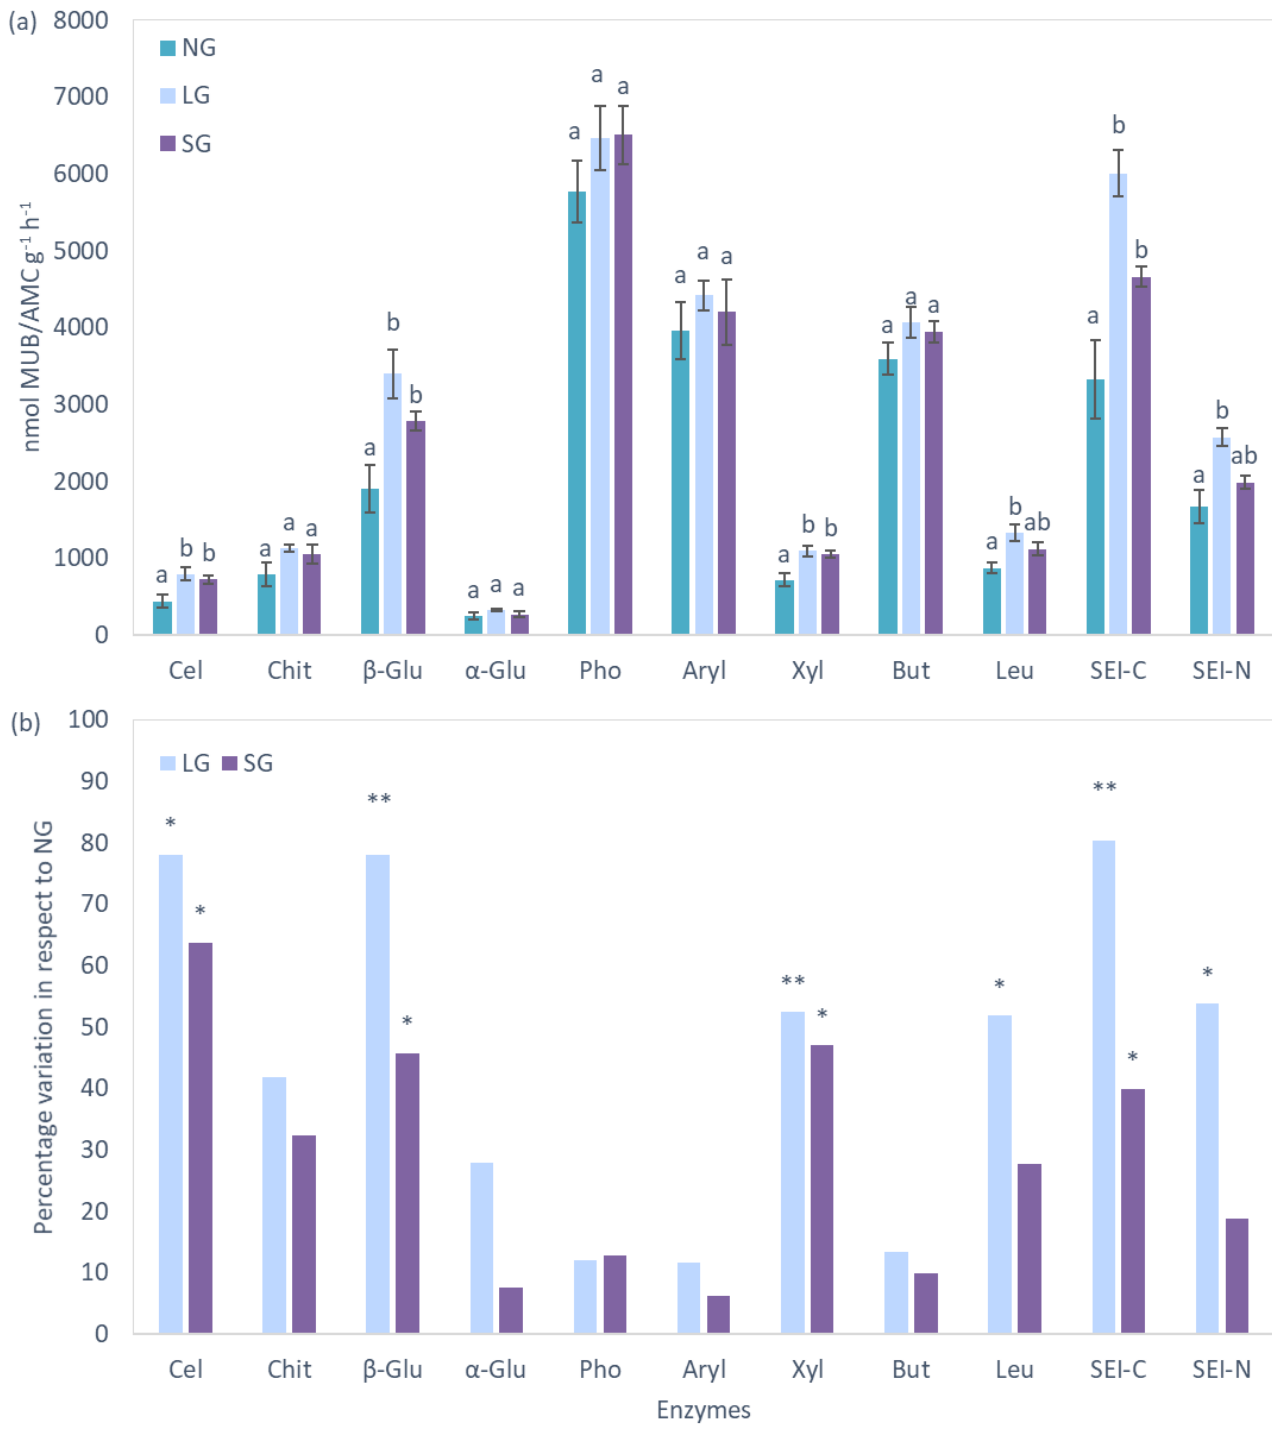
Figure 6. Soil extracellular enzyme activities and SEI index for enzymes involved in C and N cycles in grazed and non-grazed plots ( a ) absolute values (mean ± standard error), Letters next to the bars show the significance of ANOVA at p < 0.05; ( b ) percentage change in respect to non-grazed plots, significant differences with NG plots are indicated by * at p < 0.05 and ** at p < 0.01. Cel = β -cellobiohydrolase; Chit = Chitinase; β -Glu = β -glucosidase; α -Glu = α -glucosidase; Pho = acid phosphatise; Aryl = arylsulphatase; Xyl = β -xylosidase; But = butyrate esterase; Leu = leucine- aminopeptidase; SEI-C and SEI-N = synthetic enzymatic index of C and N enzymes.